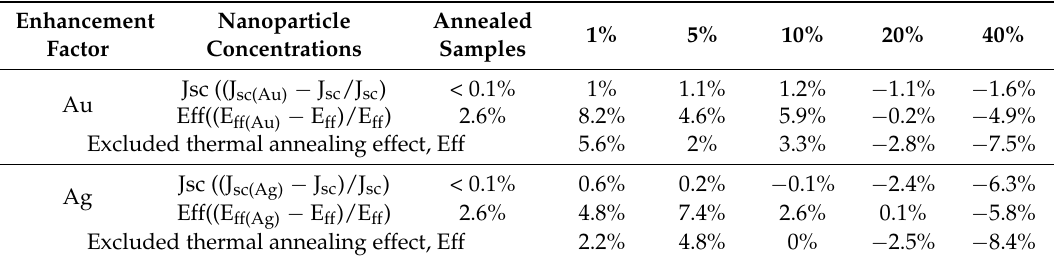
Figure 4. Current-voltage curves of mc-Si solar cells with various Au nanoparticle concentrations of ( a ) 1%; ( b ) 5%; ( c ) 10%; ( d ) 20% and ( e ) 40% under AM1.5 illumination. Table 1. The average photocurrents and efficiency enhancements of five mc-Si solar cells upon the incorporation of various concentrations of Au and Ag nanoparticles.